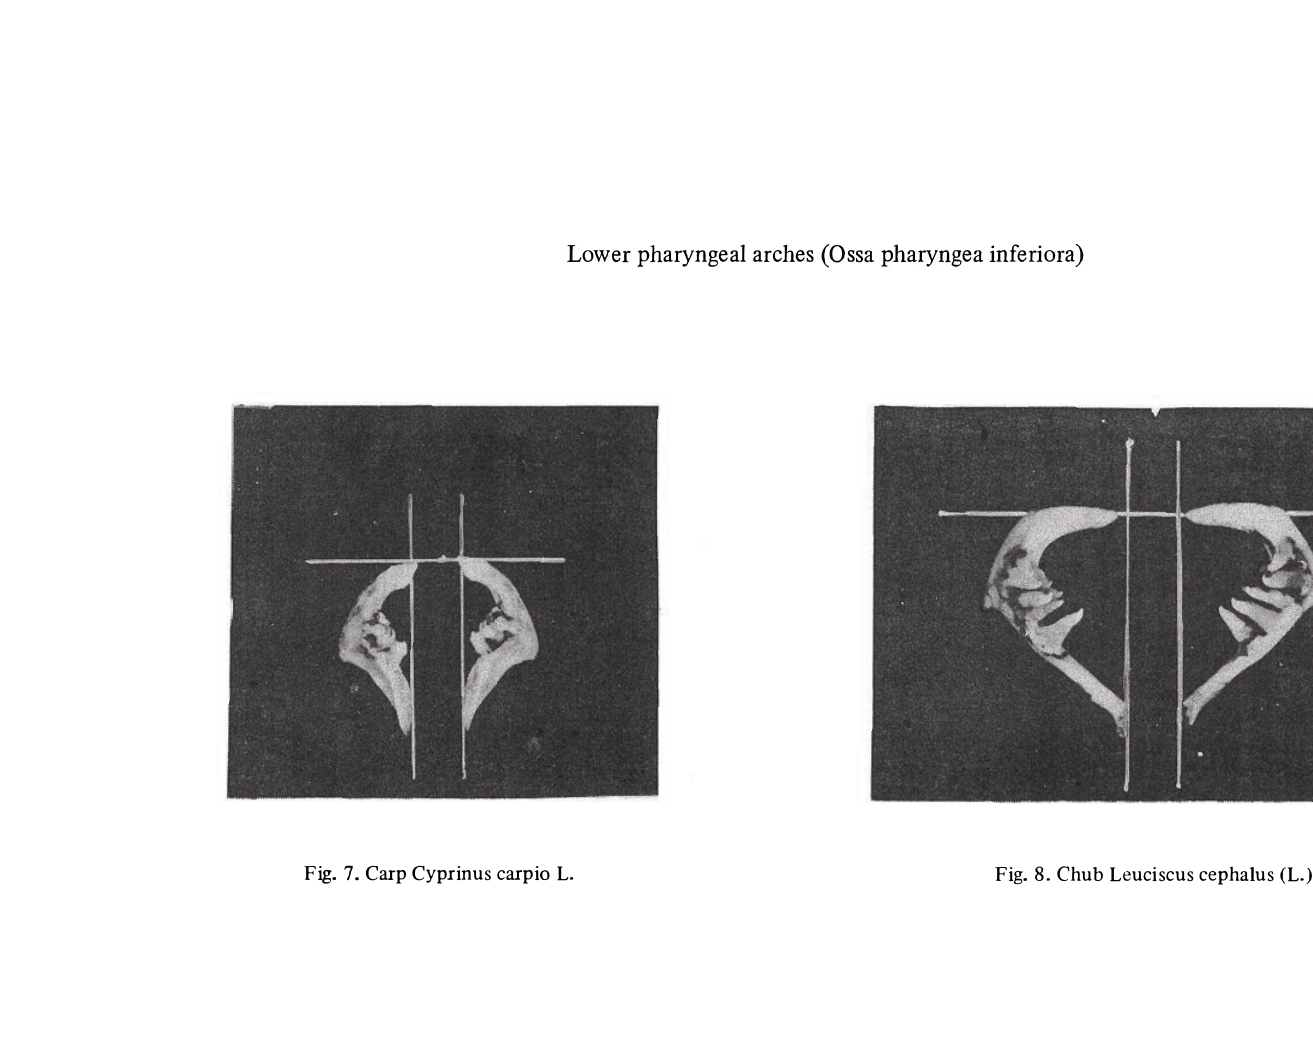
Fig. 7. Carp Cyprinus carpio L. Fig. 8. Chub Leuciscus cephalus